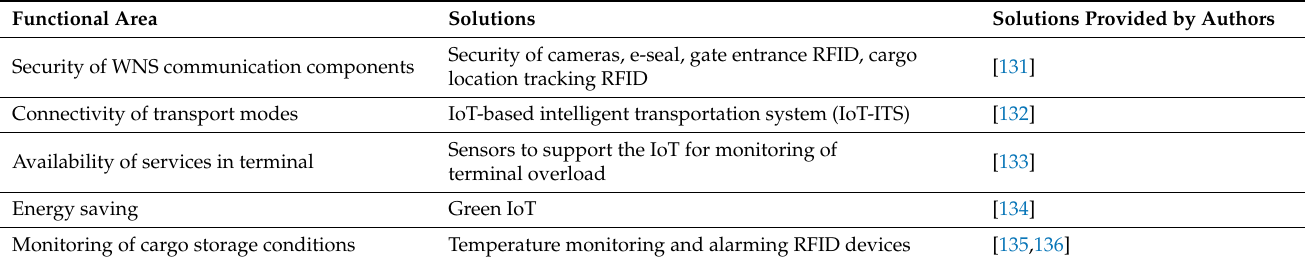
Table 3. Analysis of tasks of reporting for management of logistic and transport